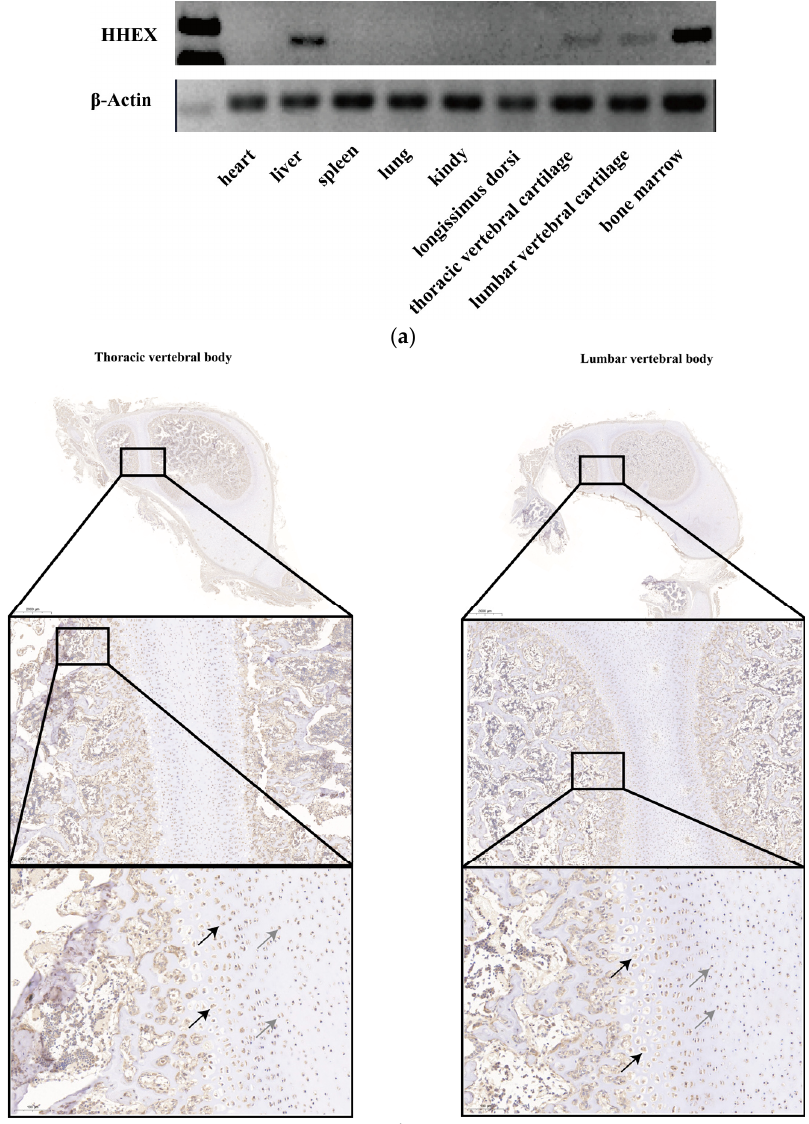
Figure 1. Porcine HHEX expression pattern. ( a ) HHEX mRNA expression in Yorkshire pig tissues ( n = 1), which were grouped based on the electrophoresis of PCR products for HHEX and β -actin. ( b ) Immunohistochemical observation of the expression of HHEX in porcine thoracic vertebral body and lumbar vertebral body tissue at 4 days of age. The arrow marks HHEX-positive cells; gray arrows indicate round chondrocytes, and black arrows indicate hypertrophic chondrocytes.